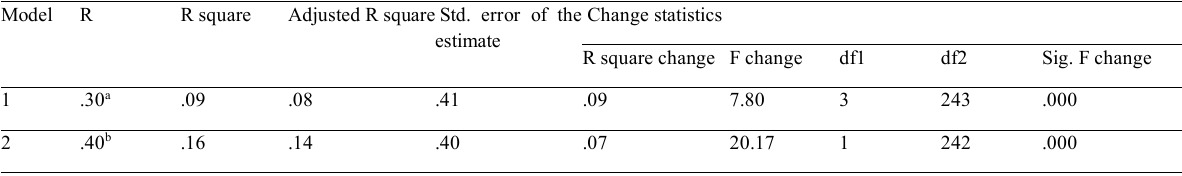
Table 2: Model summary of the moderating variable on competitive advantage Model R square Adjusted R square Std. error of the